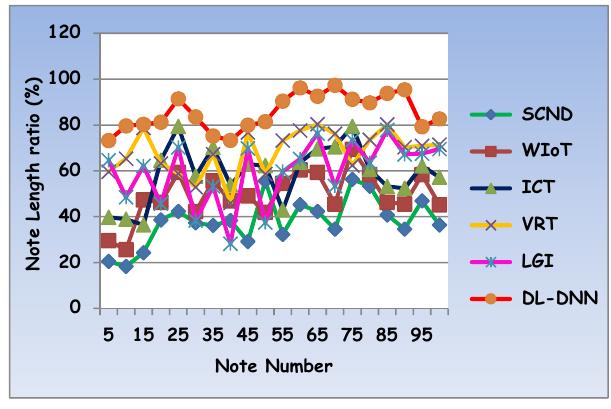
Figure 9: Distribution of landscape.